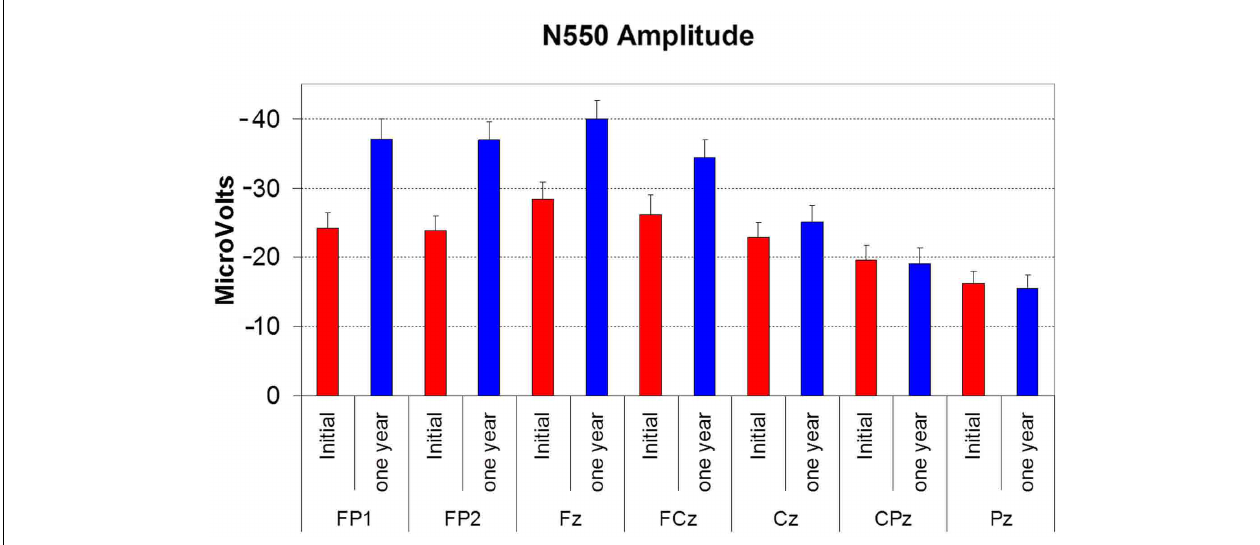
FIGURE 2 | Histogram showing the amplitude of N550 (in microvolts) at initial assessment (red bars) and at 12month follow-up (blue bars) at